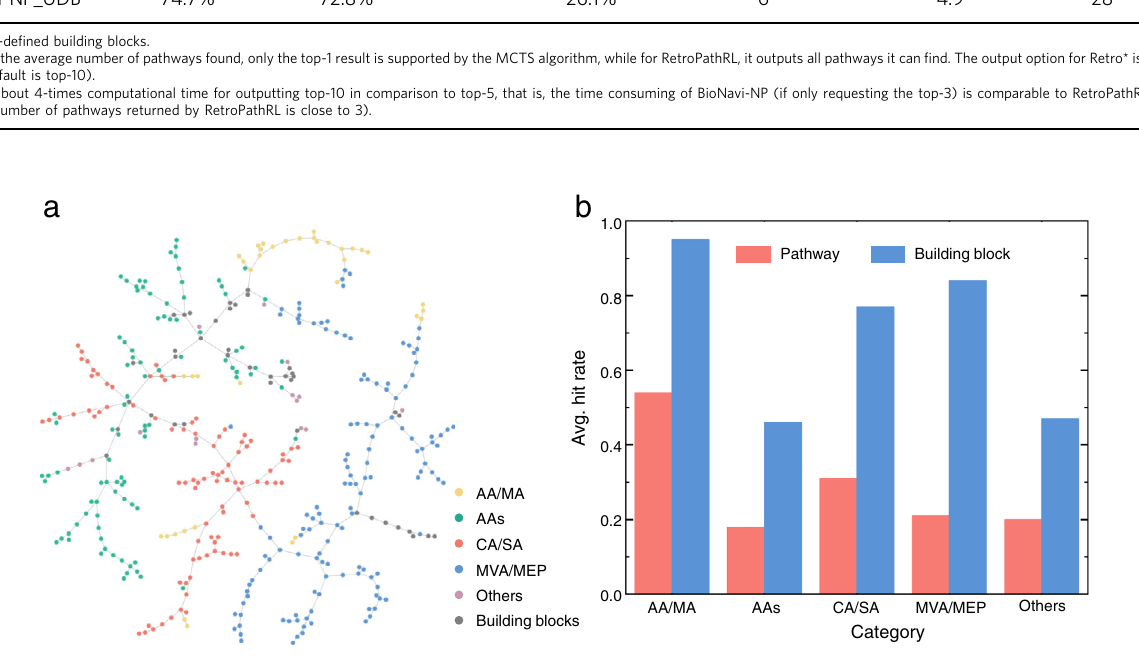
Fig. 2 The distribution and performance of internal test set. a The chemical space of internal cases in each NPs category and building blocks. The clustering and visualization of chemical space were realized by TMAP 73 using structural molecular fi ngerprints 75 . The nodes represent the structures and similar structures converge and are clustered on the same branch. The comparison of chemical space for the training set, internal cases and external cases is provided in Supplementary Fig. 4. b The BioNavi-NP ’ s performance within each NP category. Source data are provided as a Source Data fi